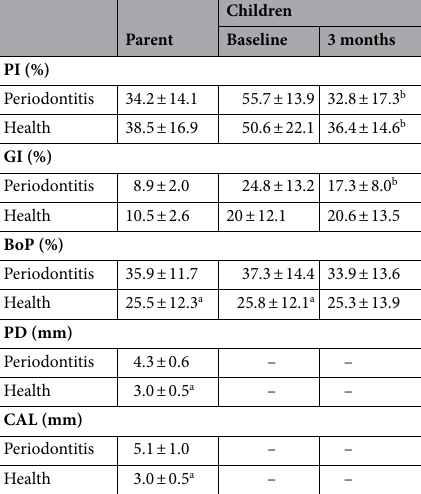
Figure 1 represents the baseline microbial assemblages in children of both groups. Chil- dren from the periodontitis group demonstrated higher species richness ( p = 0.02, Mann–Whitney test of Chao 1 index) and similar diversity ( p = 0.13, Mann–Whitney test of Shannon index, Fig. 1A), and higher relative abundances of certain species in the subgingival microbiome (Fig. 1B) when compared to the healthy group. A